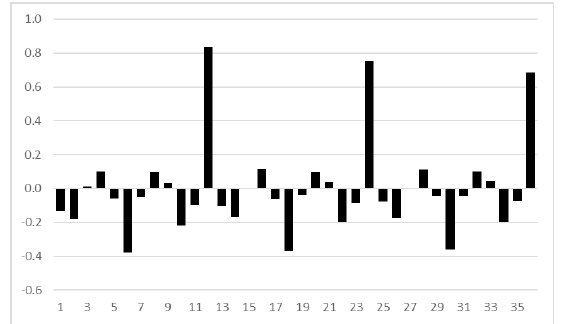
Figure A6. Turnover for wholesale and retail trade and repair of motor vehicles and motorcycles in Bulgaria (logs, seasonal